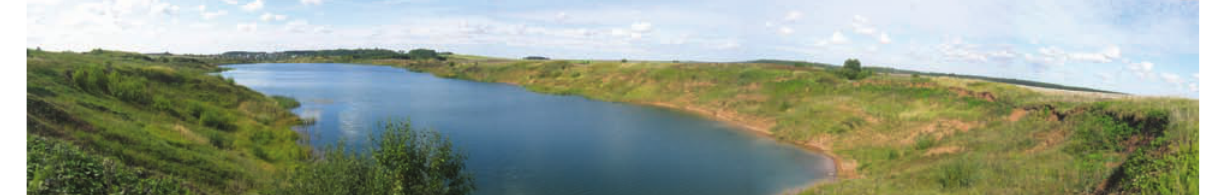
Fig. 12. Panoramic view of the Confluence Point 55°N 24°E which is in the middle of a